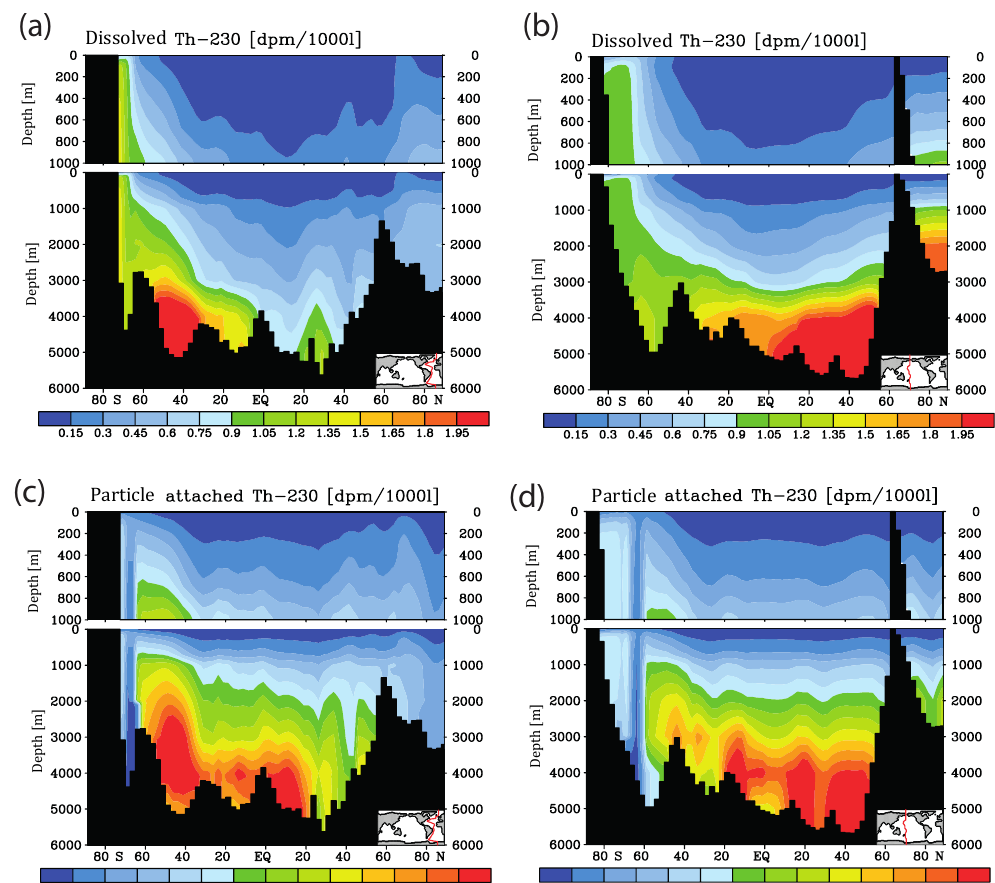
Figure 3. Meridional 230 Th cross sections in dpm/1000L (dpm indicates disintegration per minute) for the model control run under pre- industrial atmospheric CO 2 . (a) Dissolved, Atlantic. (b) Dissolved, Pacific. (c) Particle attached, Atlantic. (d) Particle attached, Pacific.